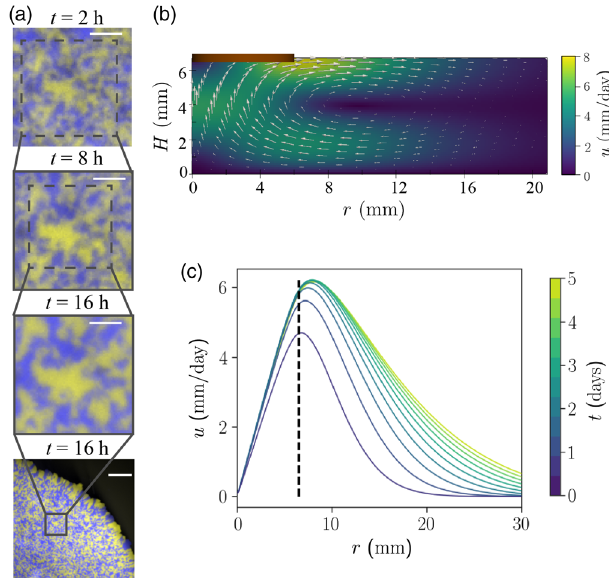
FIG. 8. (a) Magnification of experimental demixing patterns formed by two different yeast strains growing on a substrate with a viscosity η ¼ 600 (cid:2) 90 Pa s at different time points. The first three images have the same scale represented by the white bar on the upper right of the images; the scale bar corresponds to 100 μ m. The final picture at the bottom shows the same feature at the larger colony scale; the scale bar now corresponds to 500 μ m. (b) Snapshot of the simulated flow field below the yeast colony (brown bar) after flow is initiated. The simulated flow field is very similar to the one displayed in Fig. 6(a) except with a free boundary condition beneath the yeast colony. (c) Azimuthal average of the numerical flow field using the measured param- eters in Table II plotted every 12 h at the substrate fluid surface with free boundary condition beneath the yeast